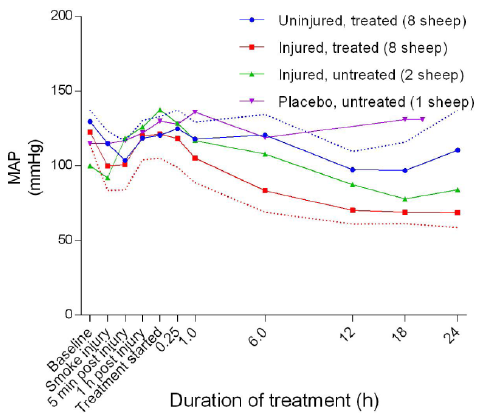
Figure 23. Mean arterial blood pressure (MAP) (Mean ± SD) in smoke and non-smoke injured sheep that received extracorporeal life support as compared to that in untreated controls. Dotted lines represent one-sided margins of error bars.